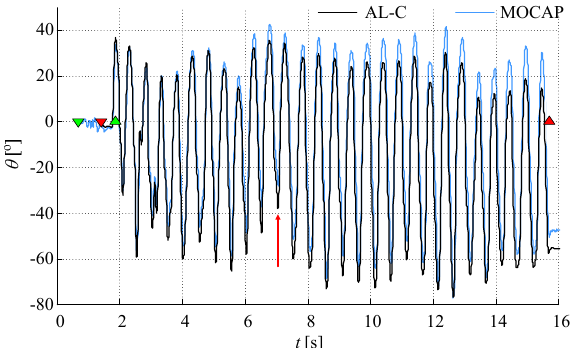
Figure 4. Tapping angle obtained from cameras and gyro sensors with the continuous (AL-C, black line) algorithm (prior to baseline removal), compared to the motion capture system (MOCAP, blue line). The signals are shown for one subject and tapping task #9 (skip tap while fingers open, marked with a vertical red arrow around 7 s). Triangles oriented downward mark the calibration sequence, while upward triangles mark the tapping sequence; start and ending are in green and red colors, respectively.